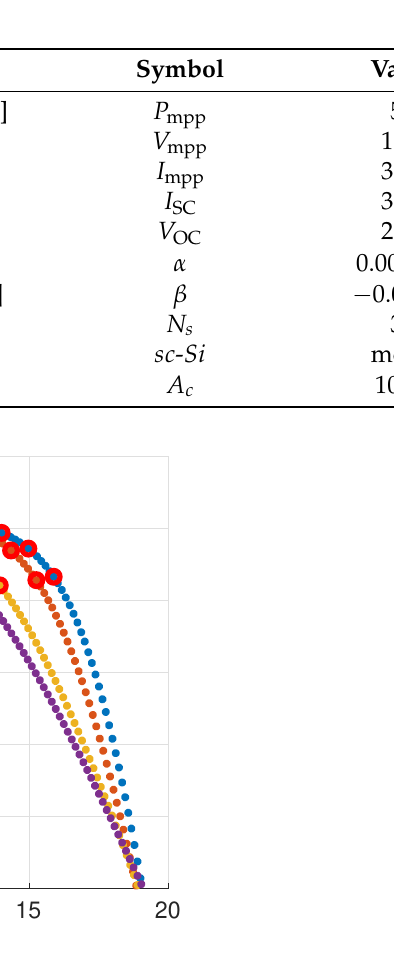
Figure 18. Experimental I - V curves with added series resistance for the same environmental